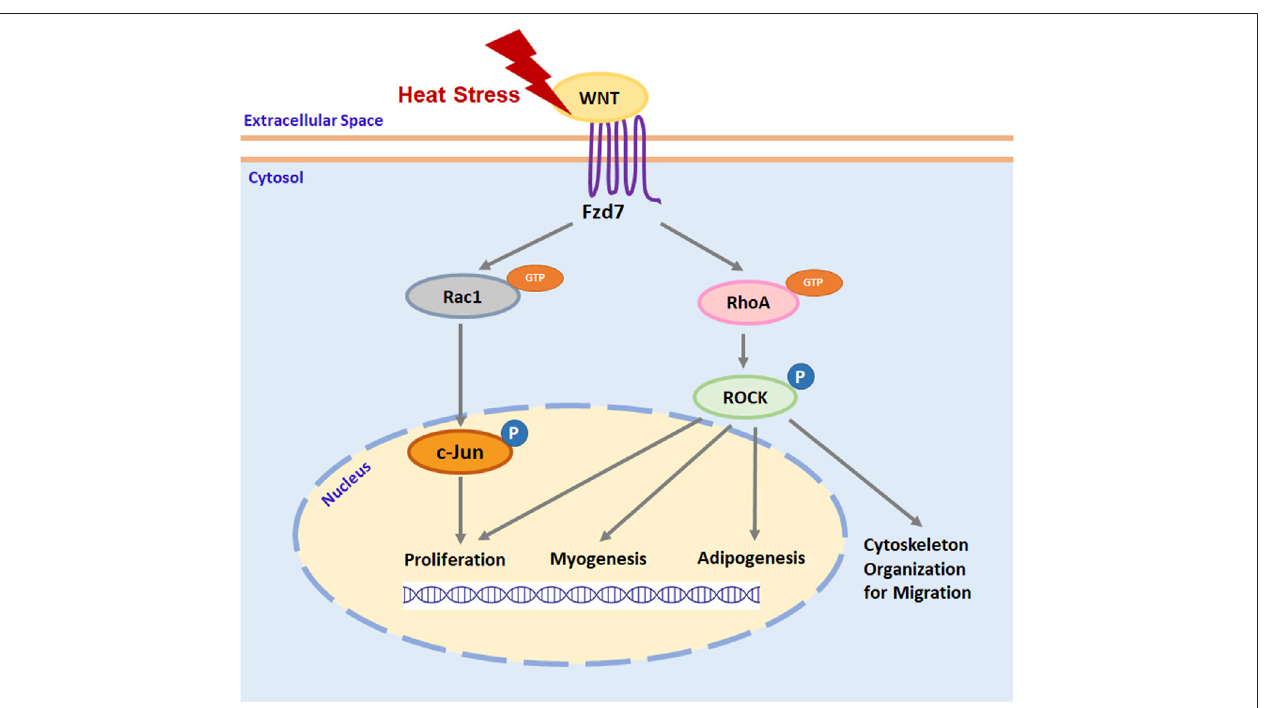
FIGURE7| Aschematicillustration ofthermalstressregulationofsatellitecellfunctionandfatethroughWntplanarcellpolaritypathway.Heatstressstimulatesthe expressionofwingless-typemousemammarytumorvirusintegrationsitefamily(Wnt)proteinligands.InteractionbetweenWntligandandcellsurfacereceptorFrizzled-7 (Fzd7) stimulates the activation of ras homolog gene family member A (RhoA) and ras-related C3 botulinum toxin substrate 1 (Rac1) by binding guanosine-5 ′ - triphosphate (GTP) to RhoA and Rac1. Activated RhoA and Rac1 will activate its downstream effector rho-associated protein kinase (ROCK) and c-Jun, respectively, by phosphorylation (P). Activated ROCK not only organizes cytoskeleton protein for cell migration but also regulates the expression of speci fi c genes that are associated with satellite cell proliferation, myogenesis, and adipogenesis. Activated c-Jun regulates satellite cell proliferation by stimulating the expression of genes promoting cell cycle progression through the G1